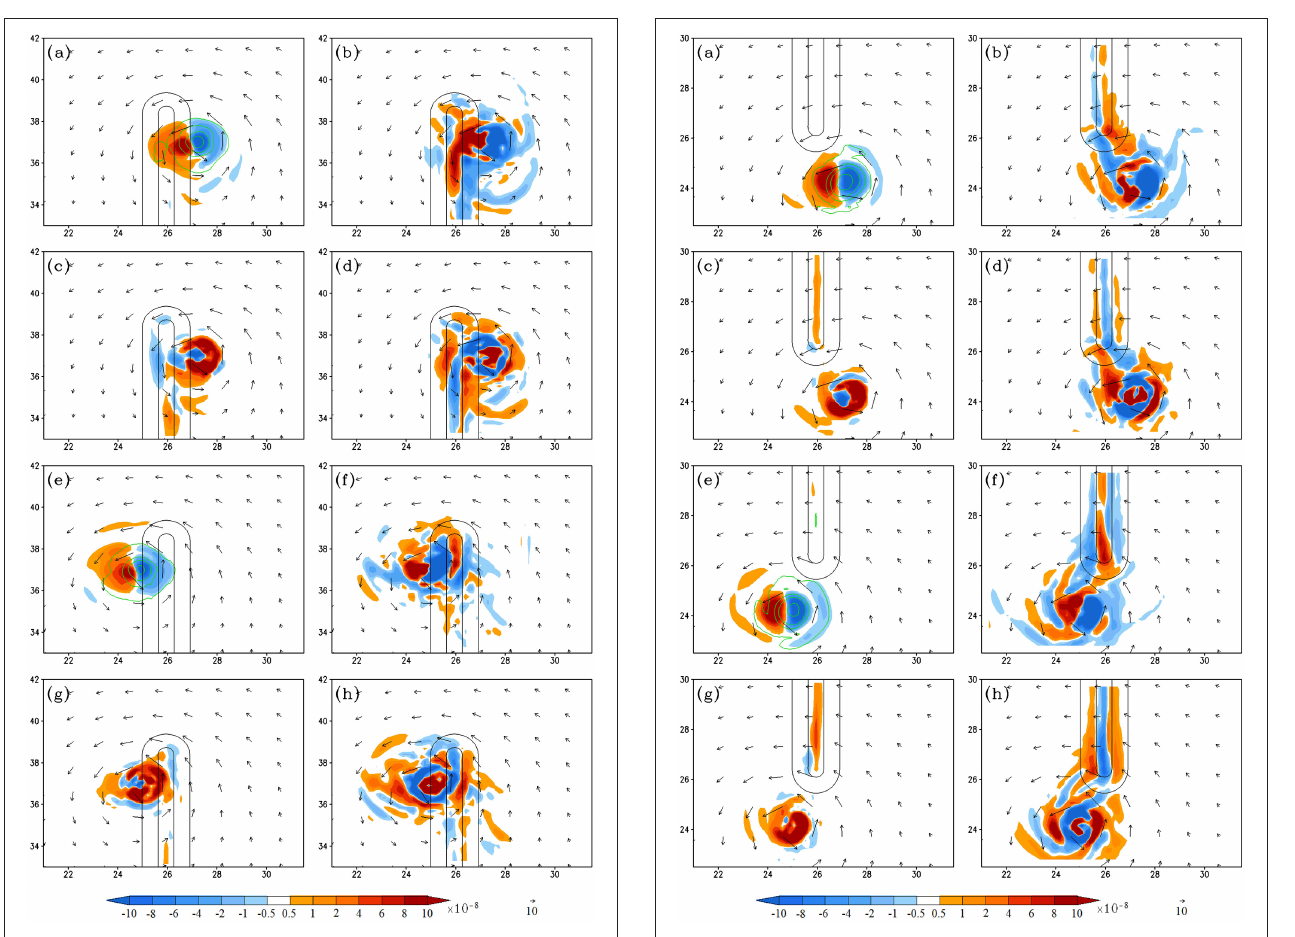
FIGURE 10 | (Track A1) The vorticity budget analysis for Track A1: (A–D) are the 950–500 hPa layer-averaged vorticity tendency (VT), horizontal vorticity advection, relative vorticity stretching, and residual term, respectively, at 171h. (E–H) Are the same as (A–D) , respectively, but at 186h. The units of the coordinates in the x and y directions are 100 km. The vertical vorticity fields are depicted by contours (0.0001, 0.0005, 0.001, 0.002, 0.003 s − 1 ) in (A,E) .